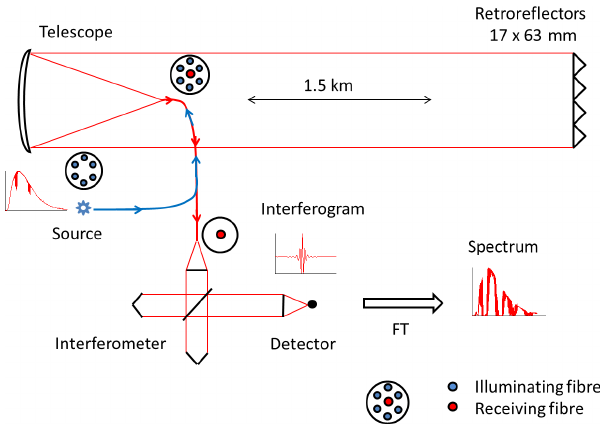
Figure 1. Schematic drawing of the long open-path FT spectrometer and optical system. Radiation from the source is fed close to the focus of the telescope through the outer bundle of six fibres (blue) and transmitted across the open path. The return beam is collected by the central fibre (red) and focussed onto the input aperture of the interferometer. The modulated beam from the interferometer is detected by the InGaAs detector and the resultant interferogram is Fourier transformed to provide the long open-path